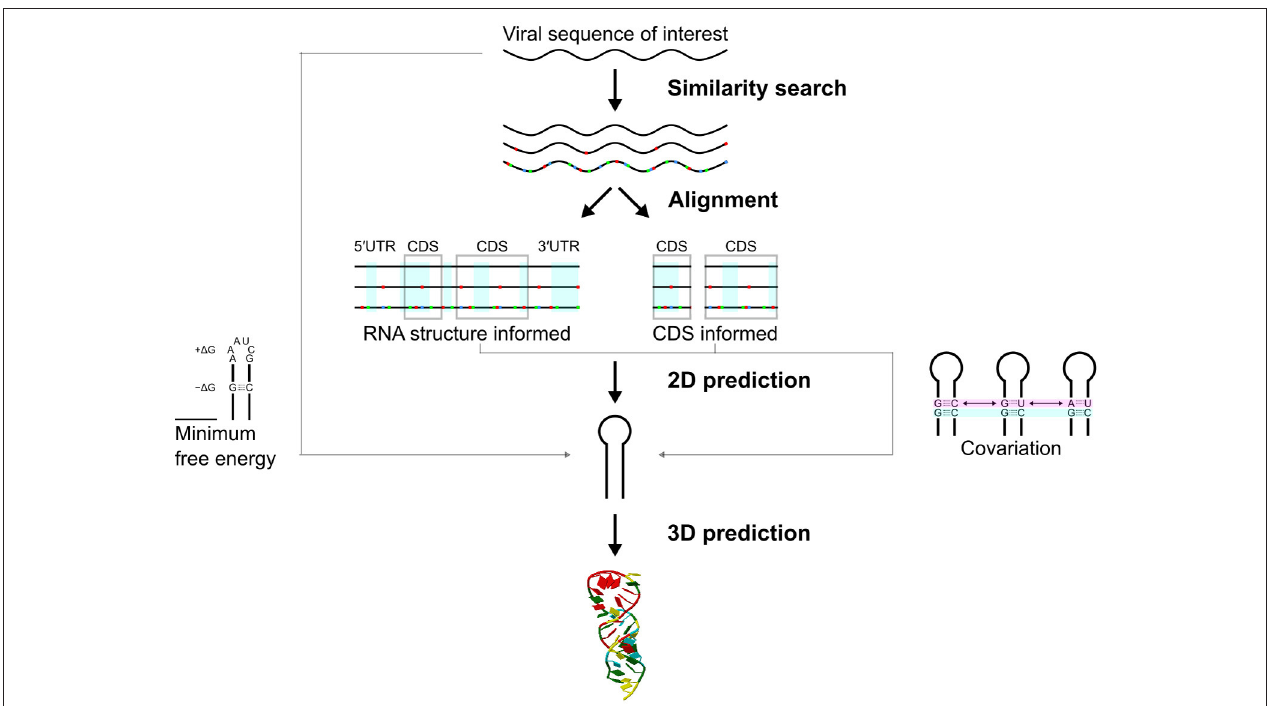
FIGURE 3 | Approaches in prediction of structured RNA elements in RNA viruses. A virus sequence of interest can be matched to the NCBI/RefSeq database (see section “KNOW YOUR ENEMY”). A range of related sequences can be aligned using RNA structure informed and/or CDS informed approaches. Structured RNA elements of a virus are likely conserved in structure rather than primary sequence (red, blue, and green dots indicate mismatches). Secondary structures can be predicted from the aligned sequence. Covariation of a secondary structure can be tested statistically. Secondary structures can also be predicted directly using minimum free energy MFE) approach. RNA 3D prediction can also be